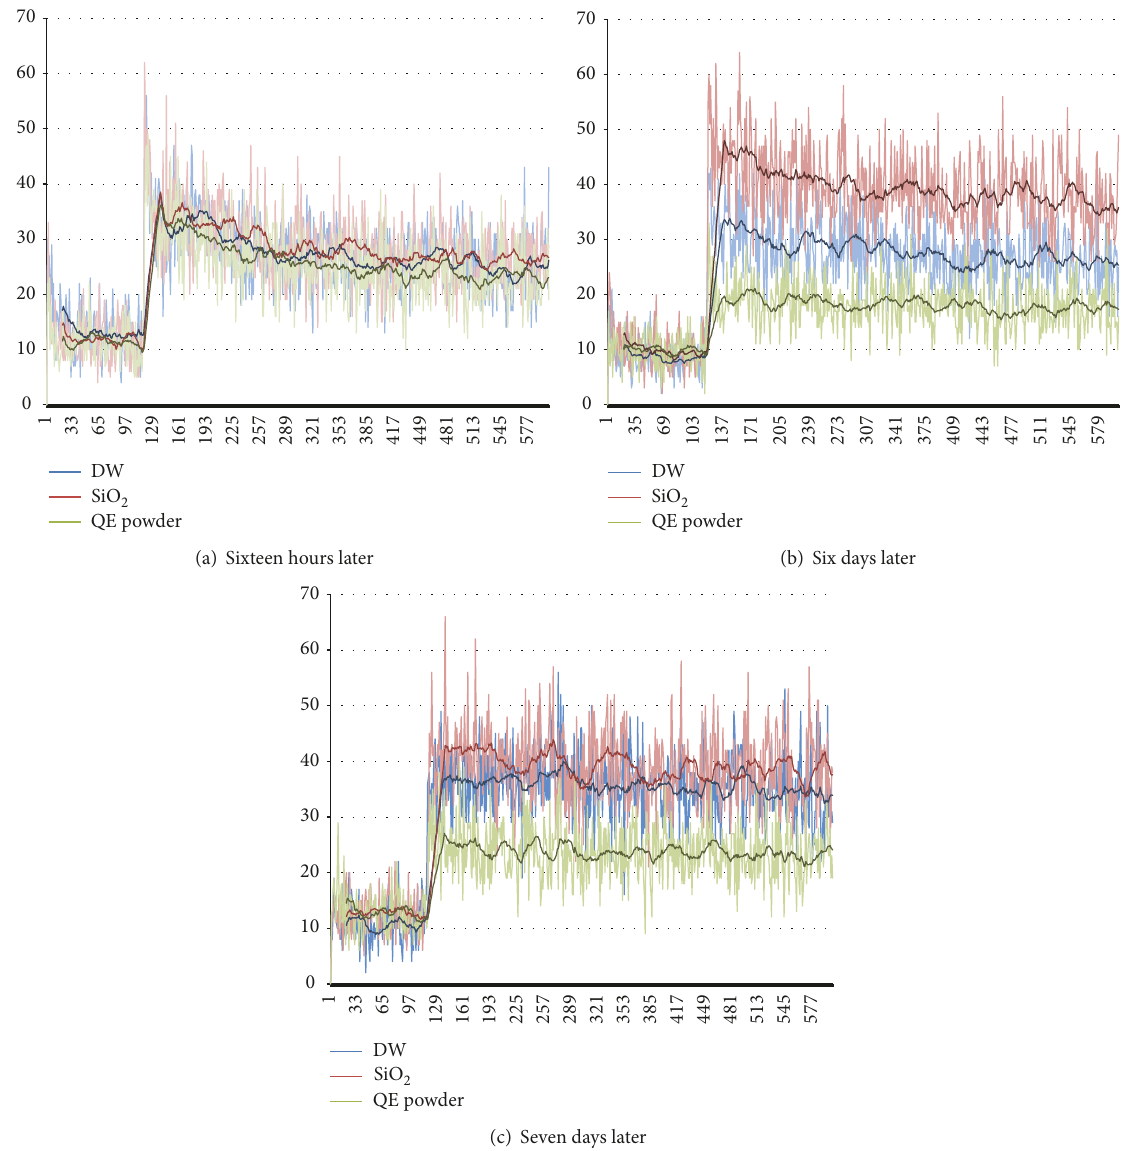
Figure 3: Measurement of ultra-weak photon emission with a photomultiplier tube . The blue line (DW), red line (SiO 2 ), and the green line (QE powder) indicate the number of photons from deionized water only, deionized water mixed with silica powder, and deionized water mixed with the QELBY powder, respectively. The number of photons per one second was measured for eight minutes. The vertical axis depicts the number of photons, and the horizontal axis represents seconds